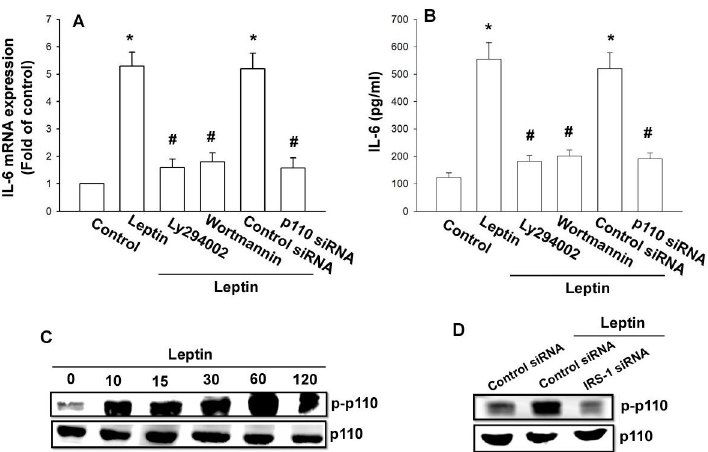
Figure 3. The PI3K signaling pathway is involved in leptin-mediated increase of IL-6 expression. (A and B) OASFs were pretreated for 30 min with Ly294002 and wortmannin or transfected with p110 siRNA for 24 h, followed by stimulation with leptin for 24 h. Media and total RNA were collected, and the expression of IL-6 was examined by qPCR and ELISA assay (n=4). (C) OASFs were incubated with leptin for the indicated time intervals. Total protein was collected and the phosphorylation of p110 was examined by western blotting (n=4). (D) OASFs were transfected with IRS-1 siRNA for 24 h and then incubated with leptin (3 µM) for 60 min; Total protein was collected and the phosphorylation of p110 was examined by western blotting (n=4). Results are expressed as mean ±S.E.M. of four independent experiments. *: p < 0.05 as compared with basal level. #: p < 0.05 as compared with the leptin-treated group.